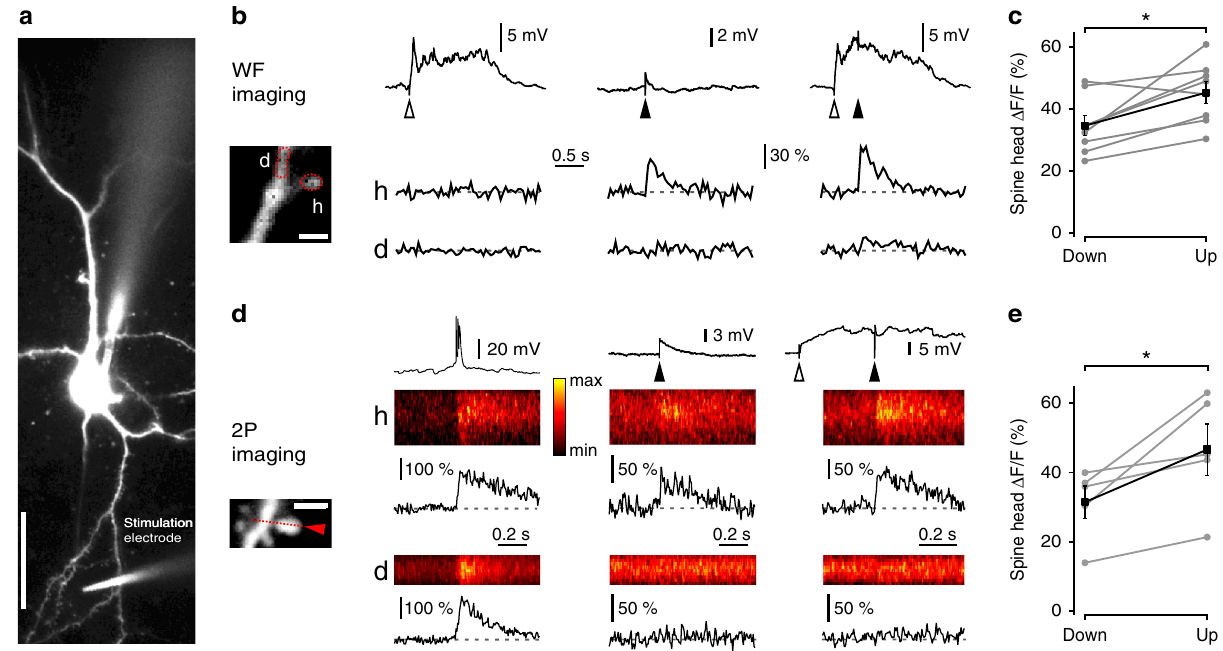
Fig. 4 Boost of the mean synaptically evoked spine Ca 2+ response during Up states. a Experimental set-up for spine Ca 2+ imaging, local synaptic activation and Up state induction (stimulation electrode for the latter not in the fi eld of view). Scale bar : 40 μ m. b In wide- fi eld (WF) imaging experiments, the cell was loaded with Alexa 594 (40 μ M) and OGB (200 μ M), for structural and Ca 2+ imaging, respectively. The inset shows the regions of interest for imaging Ca 2+ responses in the spine head (h) and neighboring dendritic shaft (d). Scale bars : 1.5 μ m. Somatic voltage responses ( top traces ), and corresponding relative changes in OGB fl uorescence ( Δ F / F ) in the spine head (h; middle traces ), and adjacent dendritic shaft (d; bottom traces ) evoked by subthreshold Up states ( left panel ), local synaptic stimulation during Down states ( middle panel ), and local synaptic stimulation during Up states ( right panel ). c Comparison of the mean spine Δ F / F responses (400 ms window) evoked by local synaptic stimulation in Down states vs. Up states across different neurons in wide- fi eld imaging experiments ( n = 8). d In two-photon (2P) imaging experiments, the cell was loaded with Alexa 594 (40 μ M) and Fluo-5F (400 μ M), for structural and Ca 2+ imaging, respectively. The inset shows the line-scan path. Example images of line-scans were fi ltered with a 3 × 3 Gaussian kernel. Scale bar : 2.5 μ m. Somatic voltage responses ( top traces ), and line scans and Δ F / F for Fluo-5F signal in the spine head (h; middle traces ), and adjacent dendritic shaft (d; bottom traces ) evoked by spontaneous Up state spike burst ( left panel ), local synaptic stimulation during Down states ( middle panel ), and local synaptic stimulation during Up states ( right panel ). The line-scan plots are scaled between the minimum (min) and maximum (max), and color-coded according to the inset key. e Comparison of the mean spine Δ F / F responses (400 ms window) evoked by local synaptic stimulation in Down states vs. Up states across different neurons in two-photon imaging experiments ( n = 5). * P < 0.05, paired t -test. Error bars show the